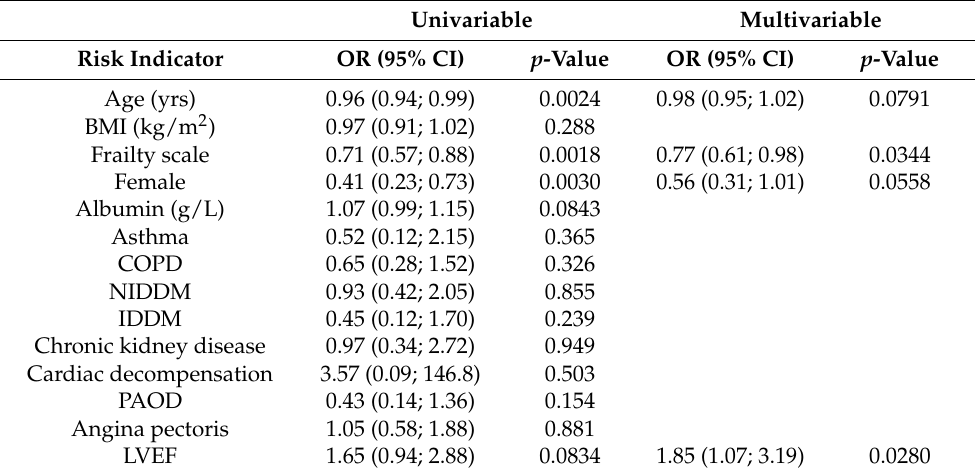
Table 2. Logistic regression analysis of risk indicators influencing the preoperative phase angle. Univariable